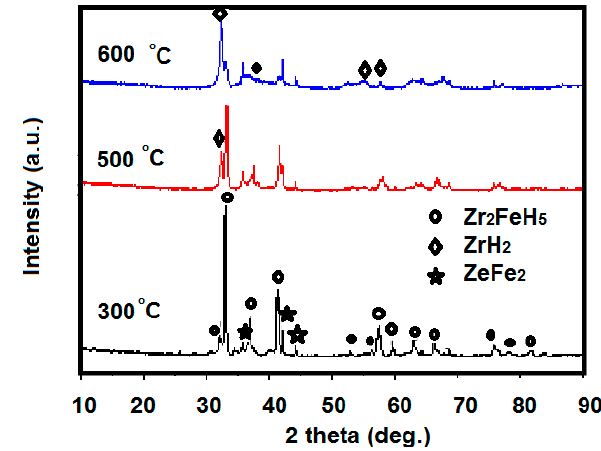
Figure 8. Kinetic curves of hydrogen absorption at 300 °C under hydrogen pressure of 0.1 MPa after activation of the alloy at 400 °C (black line); the disproportionation performance test is 300 °C (red line).